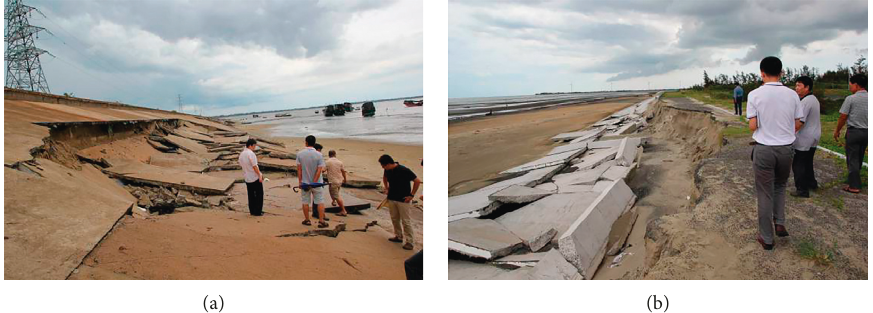
Figure 1: Sand embankment damage caused by sand loss (reproduced from Tan et al. [4]). (a) Panel breakage caused by sand loss. (b) Panel slipping caused by sand